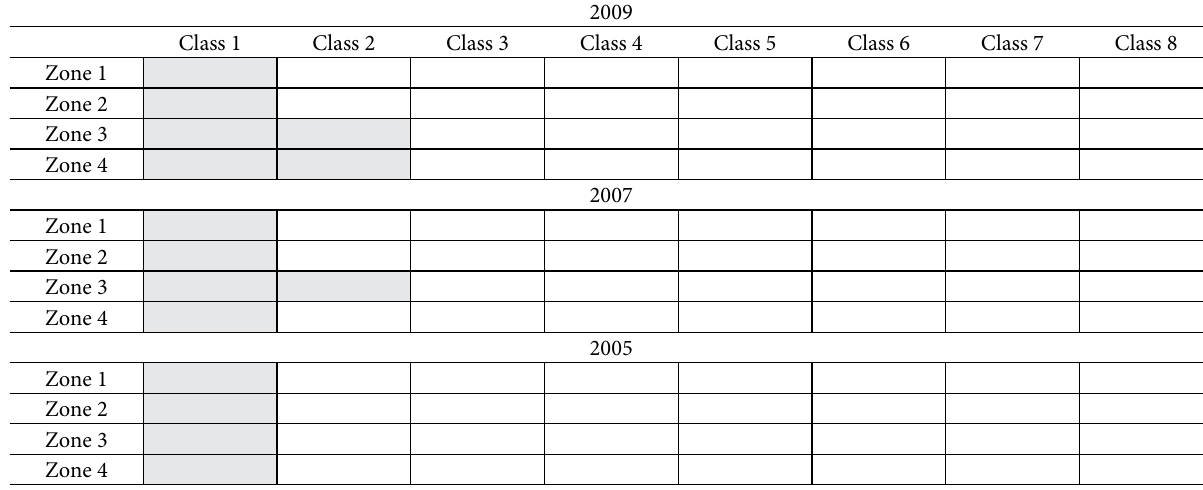
Table 5. Classes of signals (damage processes) registered in different measuring zones of one of the bridge beams under normal traffic load,